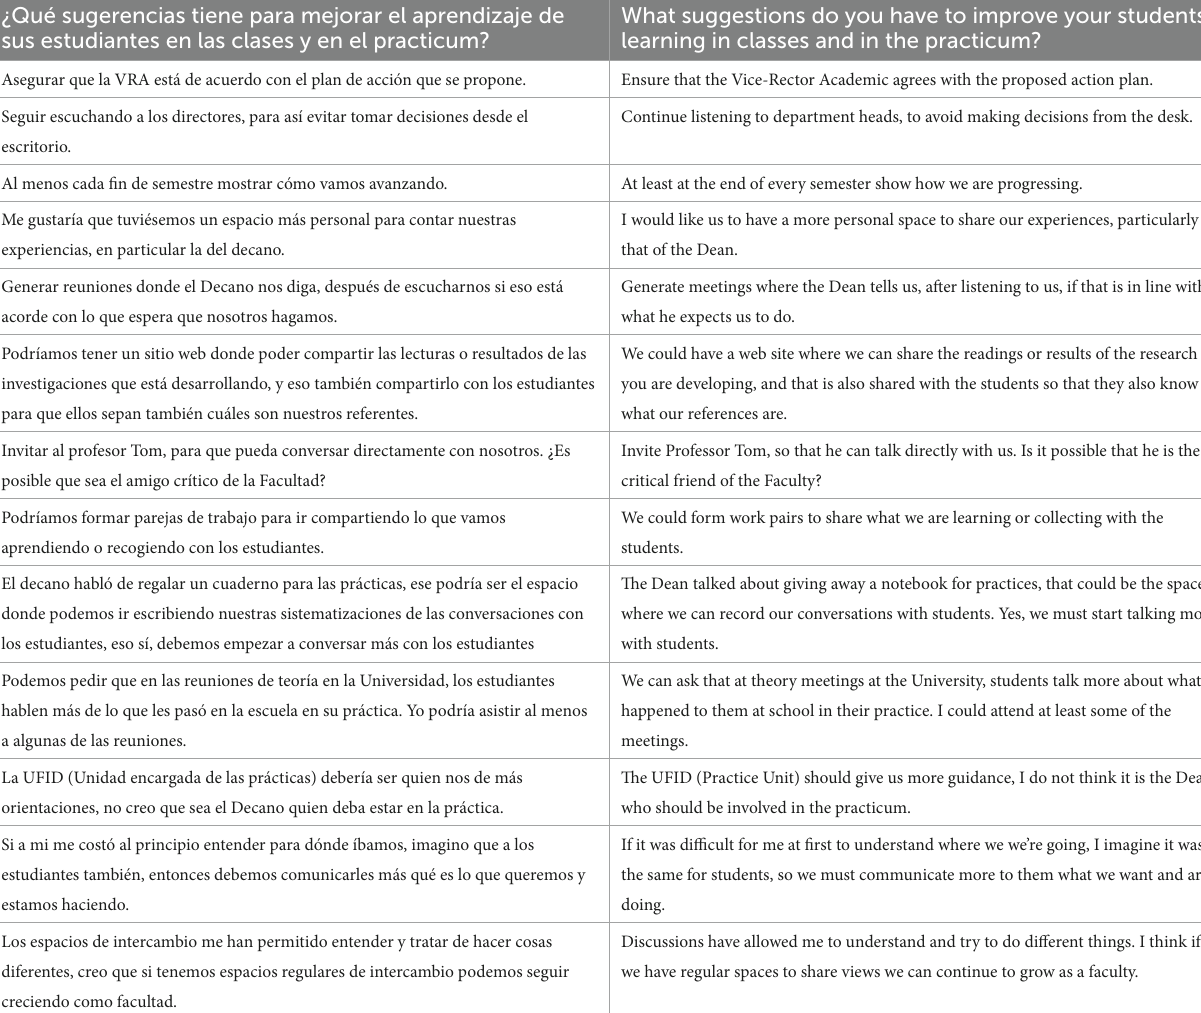
TABLE 2 Anonymous suggestions from department